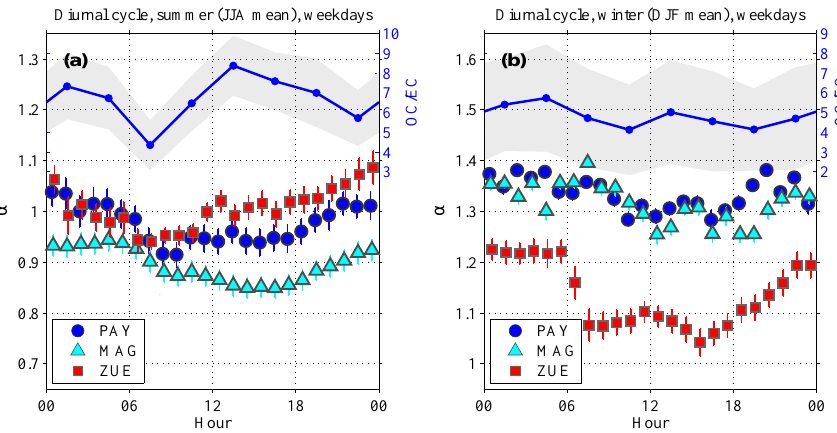
Fig. 2. Average diurnal cycle of hourly α at PAY, MAG and ZUE on weekdays during summer (June, July, August; left panel) and during winter (December, January, February; right panel). Vertical lines indicate the uncertainty band of the estimated mean values. For PAY the OC/EC ratio with one standard deviation band (grey area) is shown (3 hourly means, right axis). both figures, α is shown as hourly values calculated from measurements that were taken on working days only.